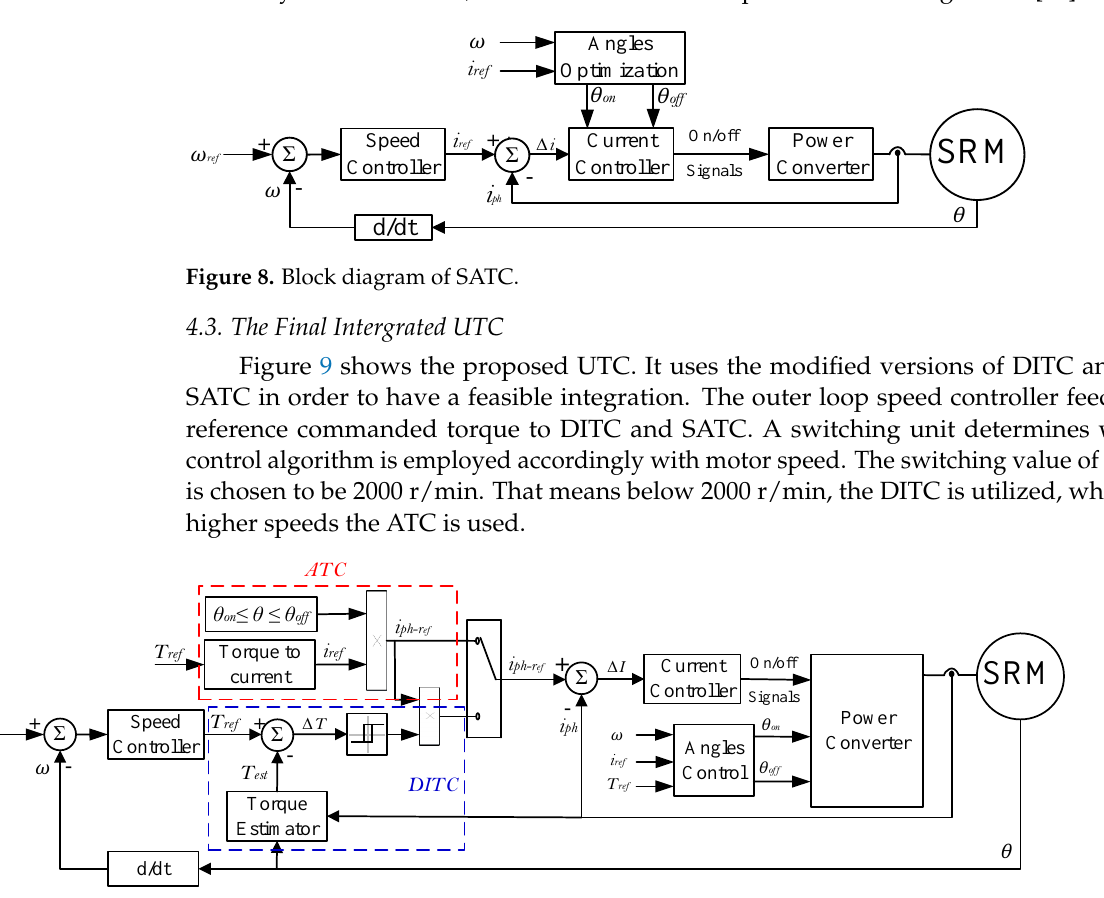
Figure 7. Torque to current conversion: ( a ) torque curves over 15°; ( b ) current versus average torque.